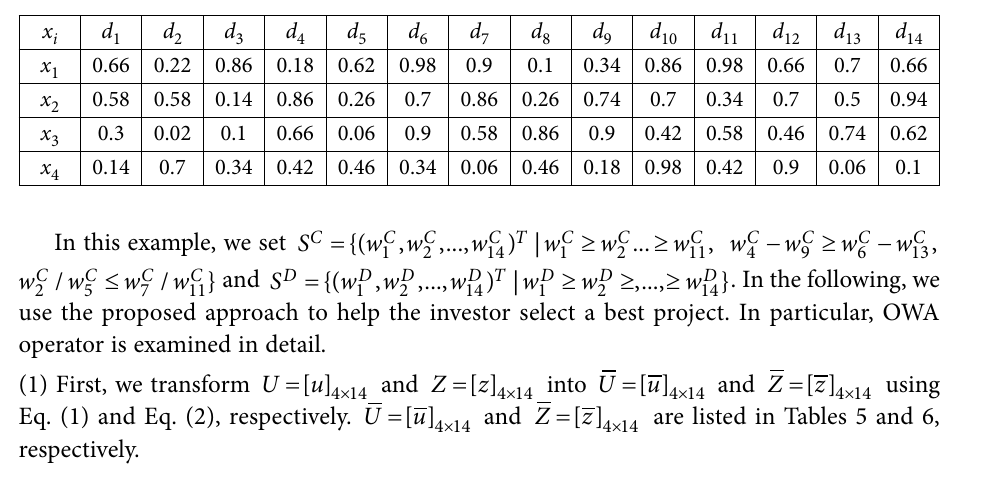
Table 4. The income evaluation matrix